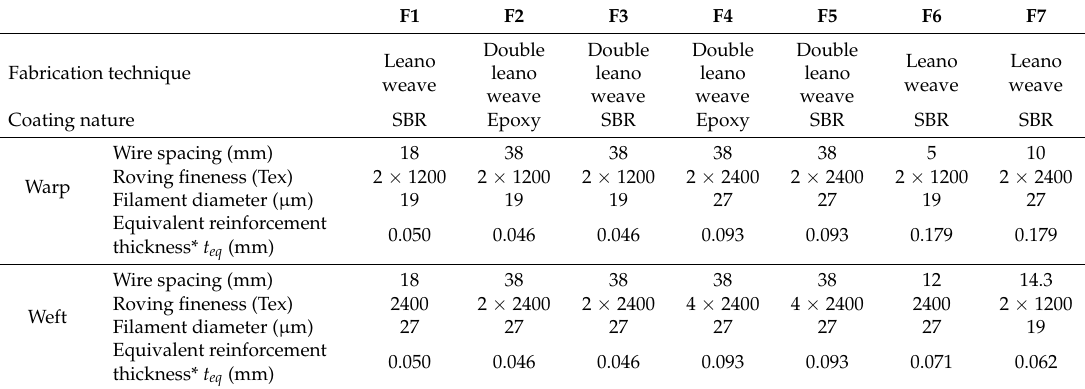
Table 4. Alkali-resistant glass fabrics characteristics.